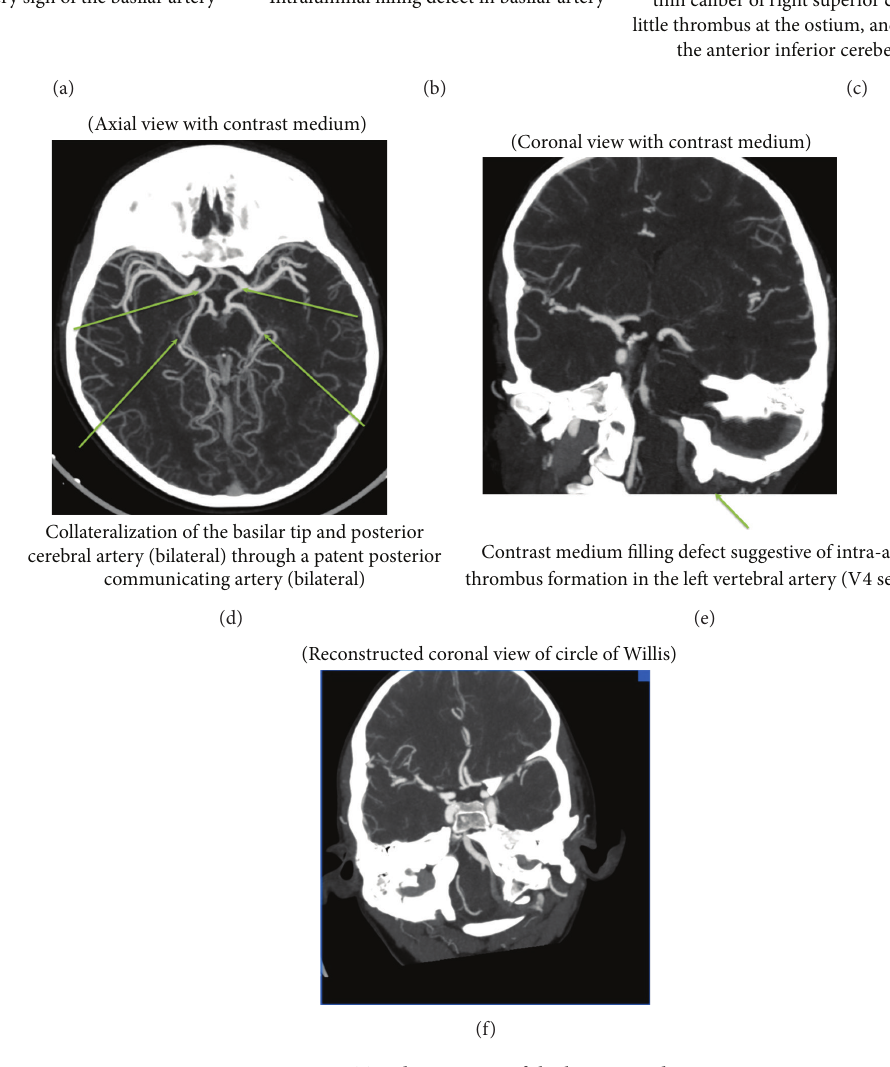
Figure 1: CAT and angioscan of the brain on